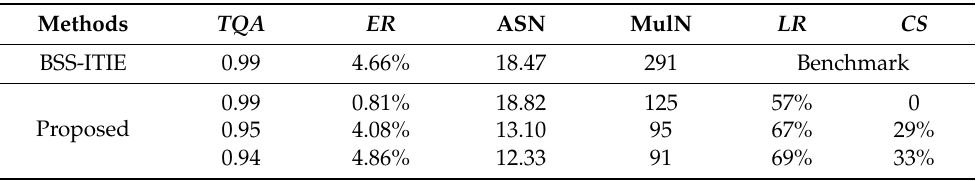
Figure 5. Bar graph representation of Table 6. Table 6. Computational savings comparison between the BSS-ITIE [28] method and the proposed algorithm.